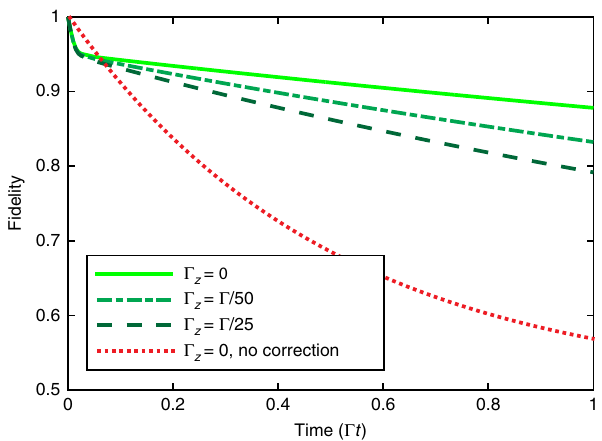
Fig. 8 Dissipative correction of spin- fl ips in the presence of dephasing. The plot shows the decrease in fi delity (compare Fig. 5) for three different values of the ratio Γ z / Γ , where Γ z ( Γ ) is the rate at which an individual phase- fl ip (individual spin- fl ip) occurs, assuming a sideband coupling G = 5000 Γ : Γ z = 0 (light green solid), Γ z = 1/25 Γ (long green dash), and Γ z = 1/ 50 Γ (short dark green dash). As reference, the plot also includes the decay of a single uncorrected ion under spin- fl ips at a rate Γ with Γ z = 0 (red dashed line), for which one observes much stronger decay of the fi